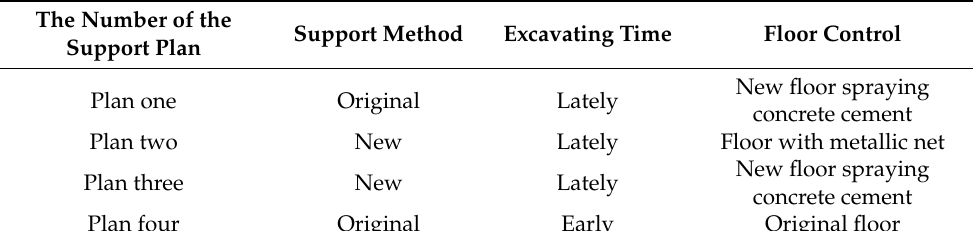
Table 3. The convergence deformation of different support plans in three months.